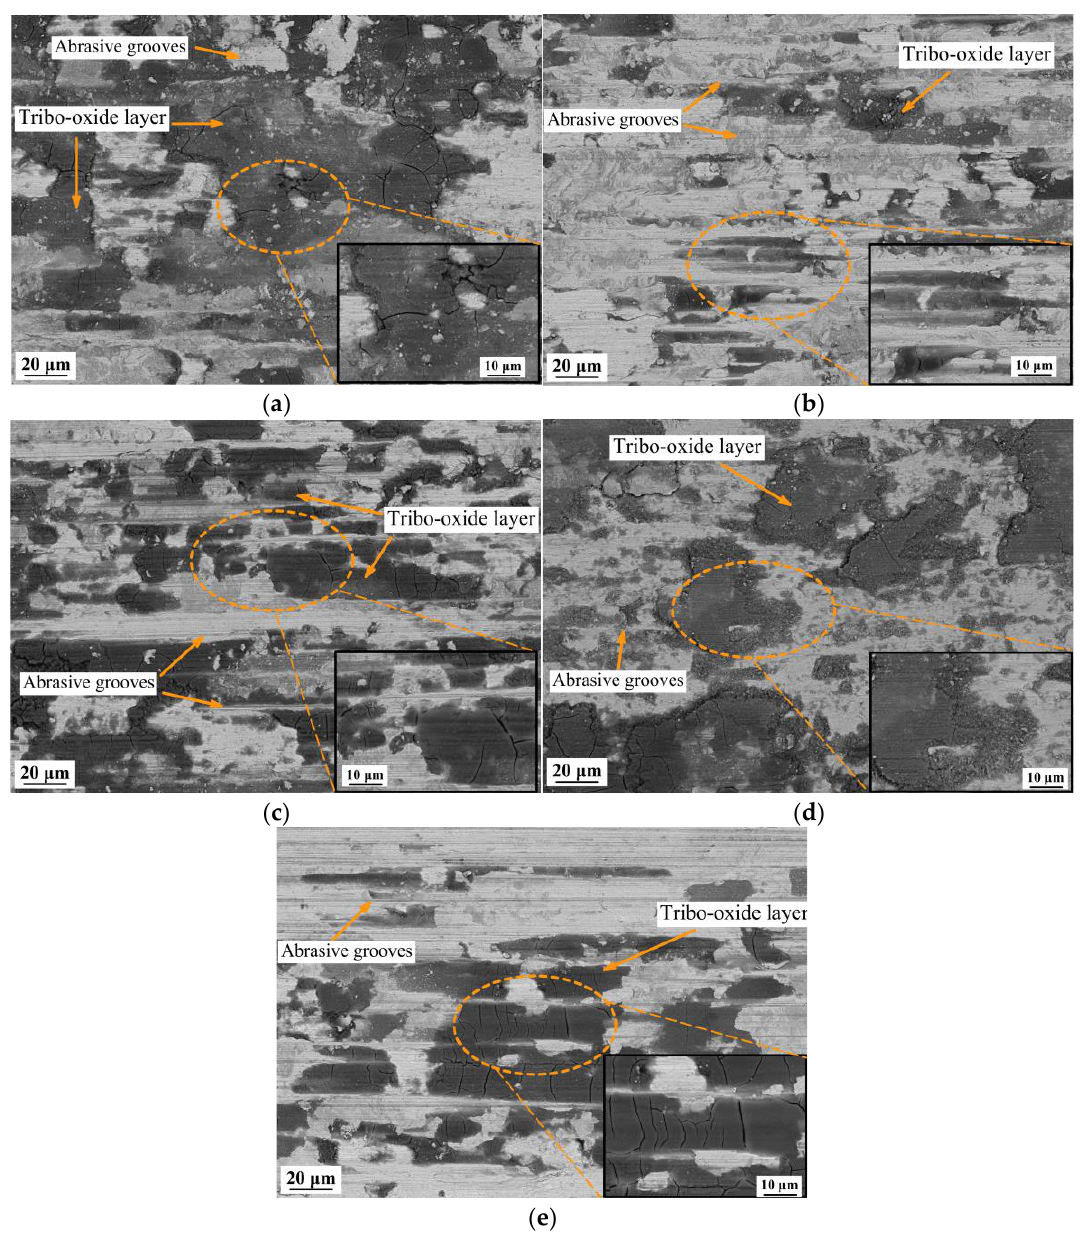
Figure 7. SEM images of the abrasive grooves in the samples: ( a ) CoCrFeNi; ( b ) CoCrCu 0.25 FeNi; ( c ) CoCrCu 0.5 FeNi; ( d ) CoCrCu 0.75 FeNi; ( e ) CoCrCuFeNi.